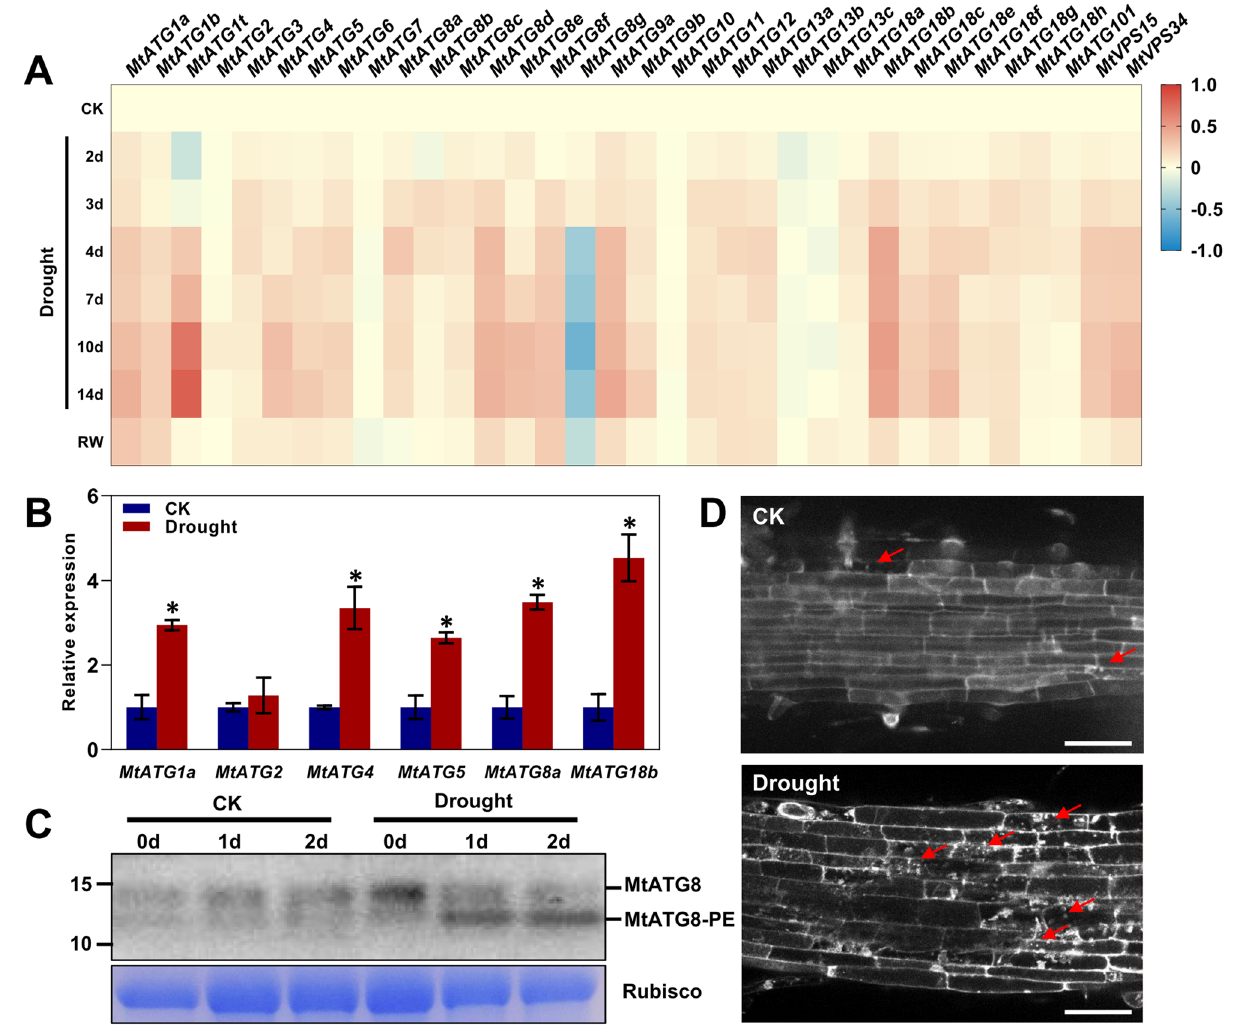
Figure 8. The expression levels of MtATGs under drought stress. ( A ) Gene expression of MtATGs from microarray data under drought stress. For drought stress treatment, soil-grown plants were subjected to drought stress by withholding watering (Drought) for 14 days, followed by rewatering. Scale bar represents the fold change (log2 value) relative to the corresponding control. ( B ) qRT-PCR validation of MtATGs expression under drought stress. For drought stress treatment, 7-day-old seedlings were subjected to drought stress by withholding watering for 2 days. MtACTIN was used as a reference gene. Error bars represent SD of three independent experiments. Significant differences were indicated with an asterisks (*), P < 0.05. ( C ) Analysis of ATG8 lipidation by western blot. Two week seedlings were transferred to liquid 1/2 MS medium with or without 300 mM mannitol, and whole seedlings were collected at 0, 1, and 2 day after treatment. The anti-ATG8a antibodies were used for immunoblotting. ( D ) MDC staining of root cells with or without drought treatment. Two-wk-old seedlings were transferred to liquid 1/2 MS medium with or without 300 mM mannitol for 2 days followed by staining with MDC. The labeled autophagosomes (arrows) were visualized by epifluorescence microscopy. Scale bar: 50